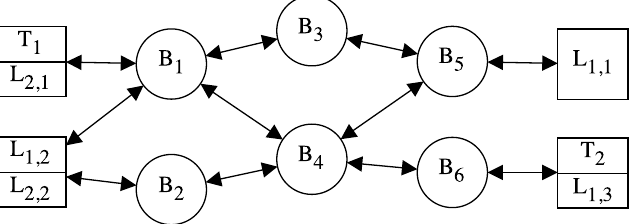
Figure 3. An example of a TSN-based network architecture with four end-systems and six bridges in a mesh topology. End-systems are represented with squares, bridges with circles and links with arrows. The T means that the end-system is a talker, while the L means it is a